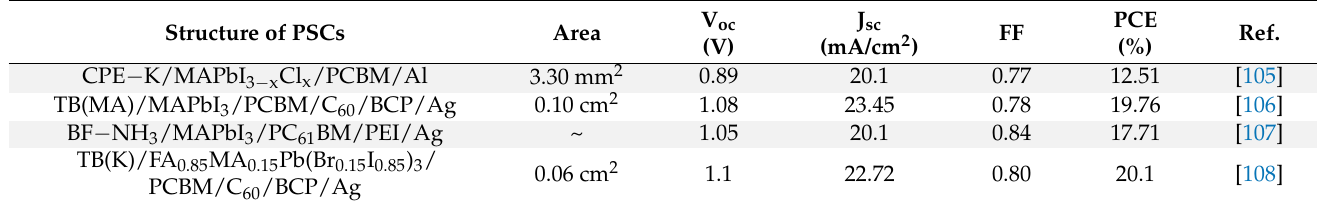
Table 7. Performances of several representative inverted PSCs on the basis of the different CPE HTL